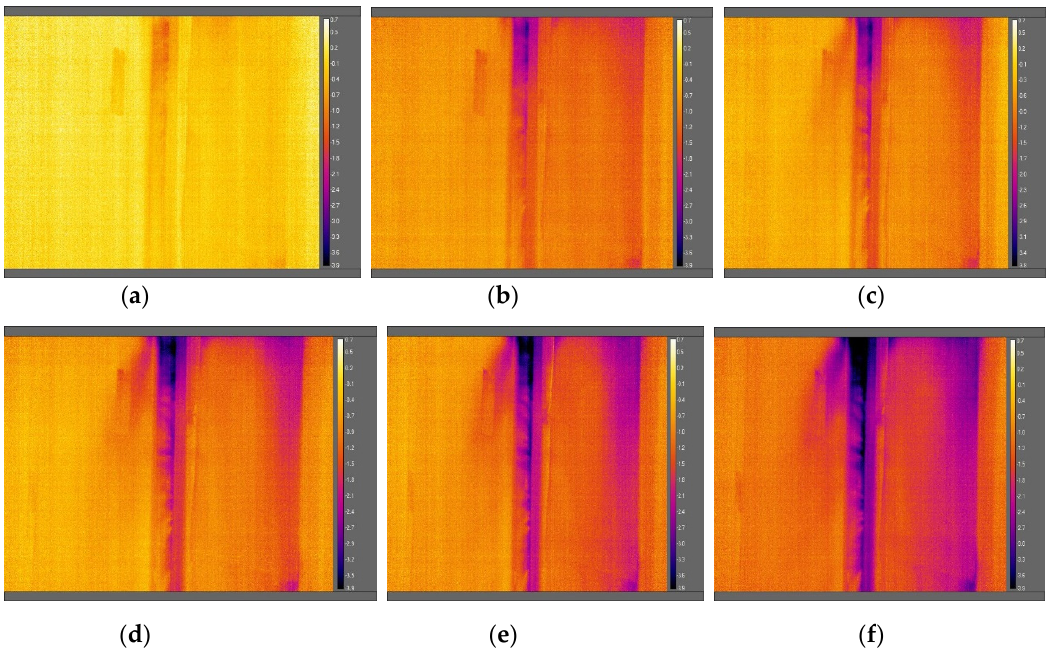
Figure 6. Subtracted thermograms ( a ) ( ∆ P = 15 ) − ( ∆ P = 0); ( b ) ( ∆ P = 25 ) − ( ∆ P = 0 ) ; ( c ) ( ∆ P = 35 ) − ( ∆ P = 0 ) ; ( d ) ( ∆ P = 45 ) − ( ∆ P = 0 ) ; ( e ) ( ∆ P = 55 ) − ( ∆ P = 0 ) ; ( f ) ( ∆ P = 65 ) − ( ∆ P = 0 )